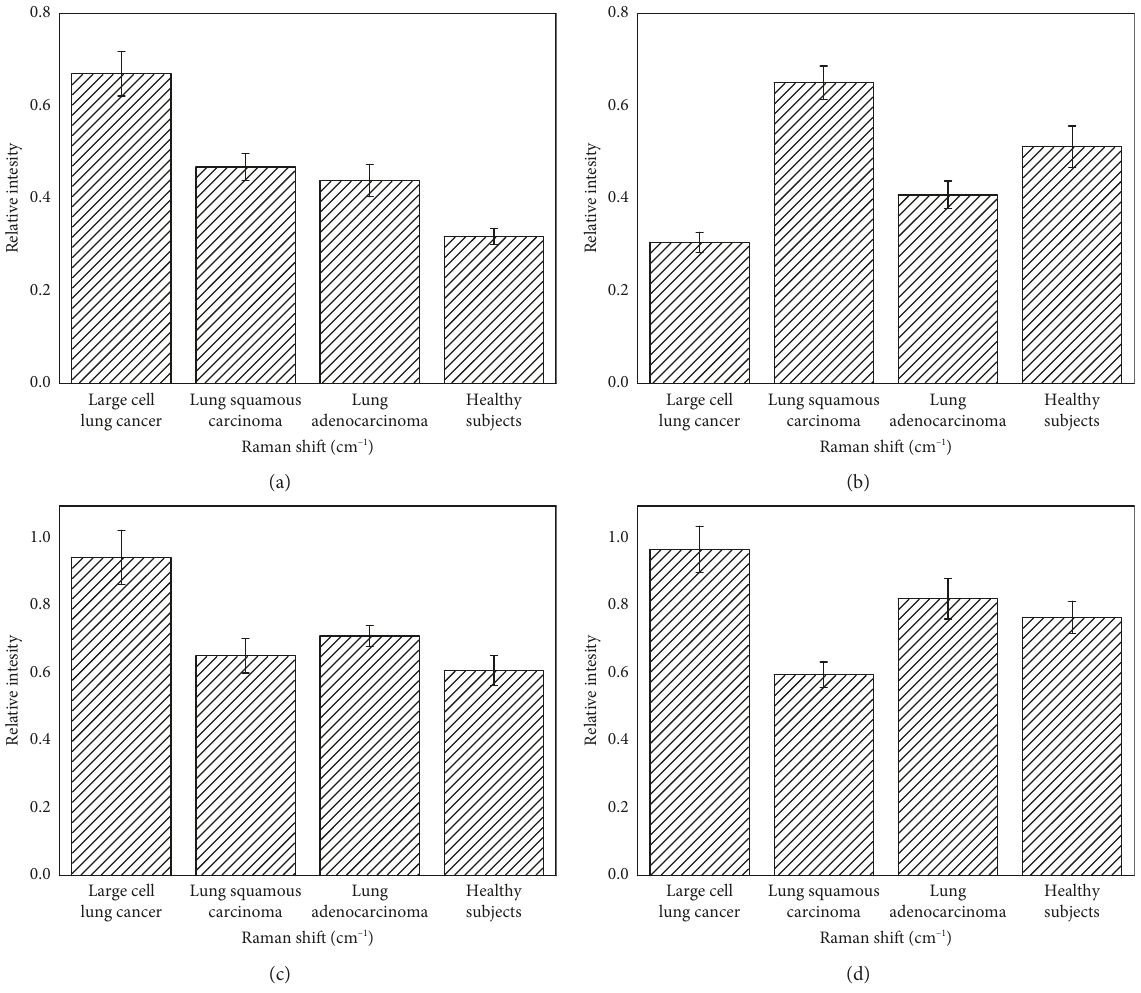
Figure 7: The comparison of mean relative intensity at (a) 728cm − 1 , (b) 1079cm − 1 , (c) 1318cm − 1 , and (d) 1466cm − 1 among four